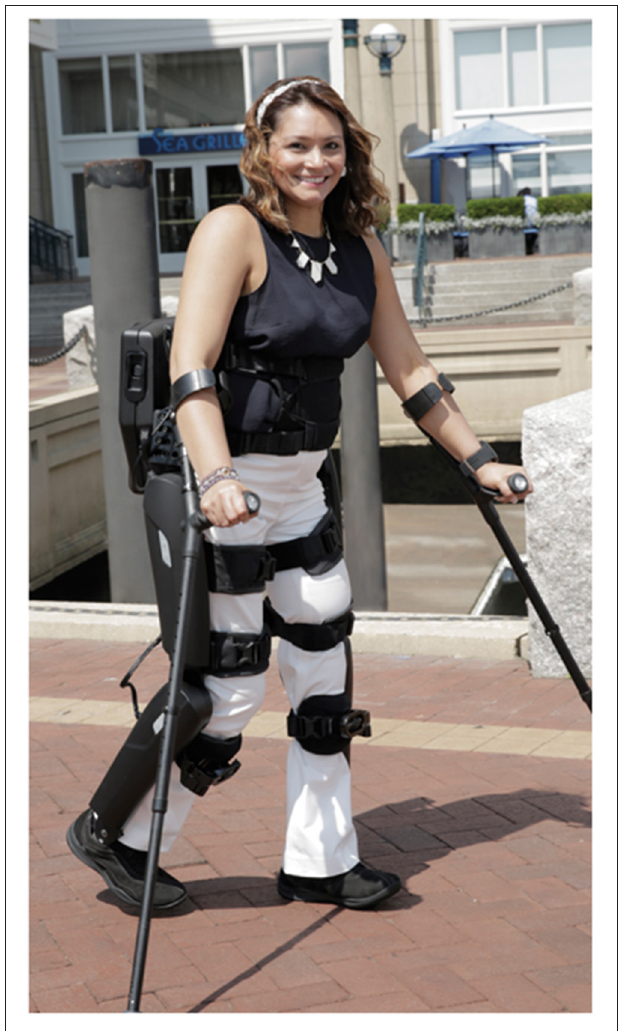
FIGURE 1 | The ReWalk TM Exoskeleton. Source: https://rewalk.com/rewalk-